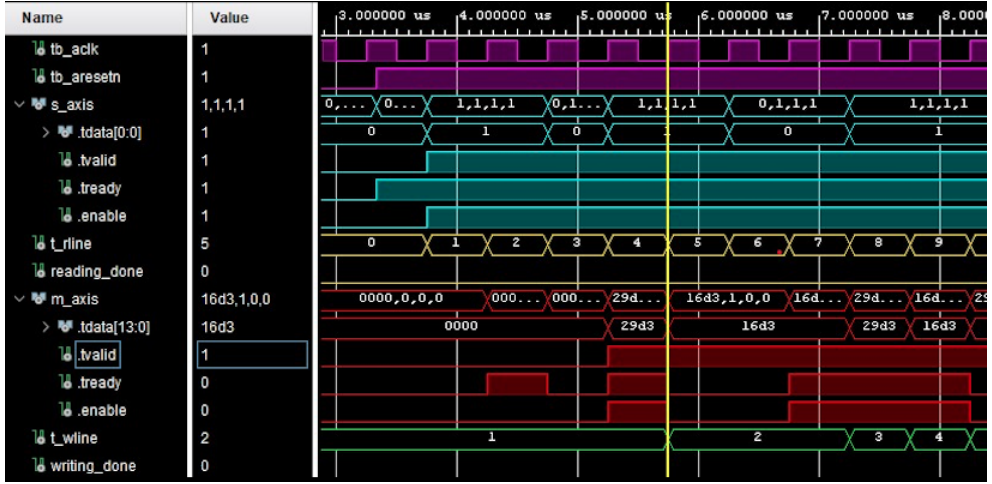
Figure 21. Timing diagram for the first 8 output bits after initialization.